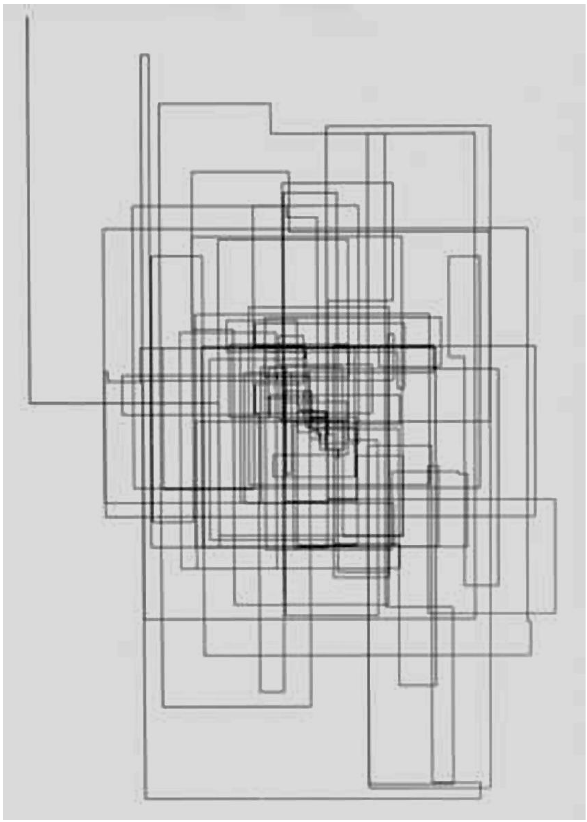
Figure 1 | Georg Nees: Irrweg 1965. Credit: G. Nees